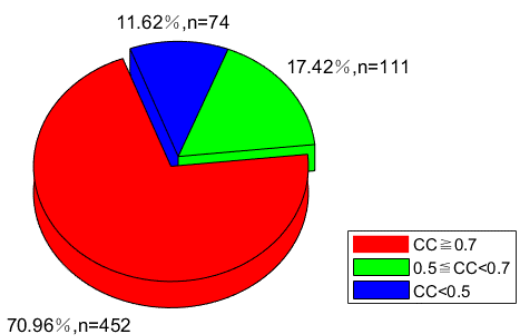
Figure 6. Pie chart of the CCs between PWV and ellipsoidal height of original points.